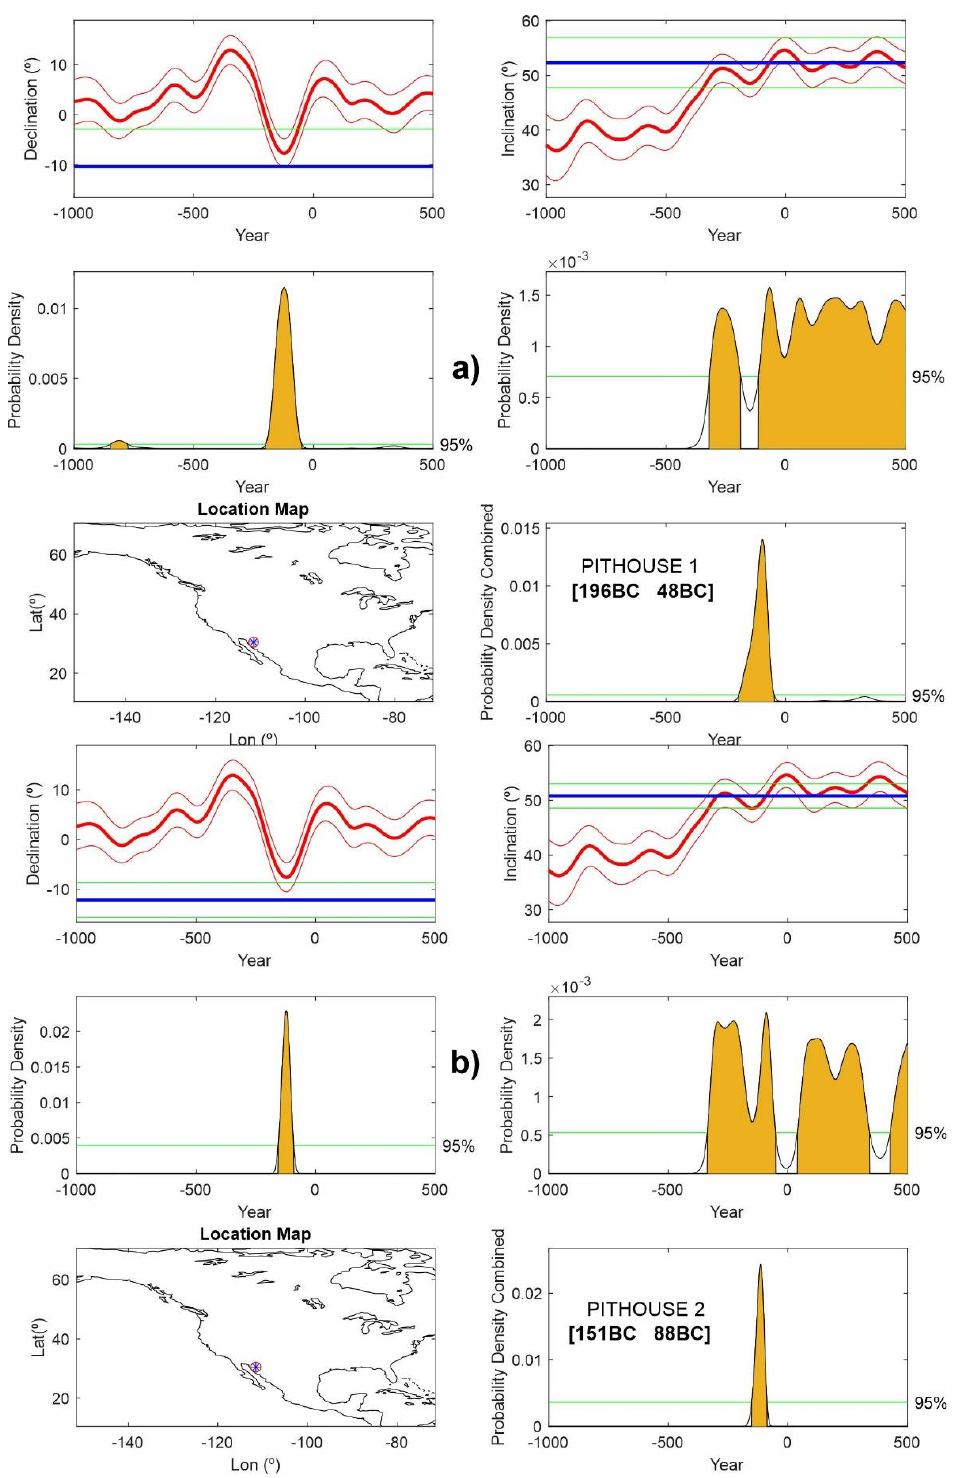
Figure 7. Archaeomagnetic dating using SHA.dif.14k global geomagnetic model [33,34] for Pit House 1 and 2.